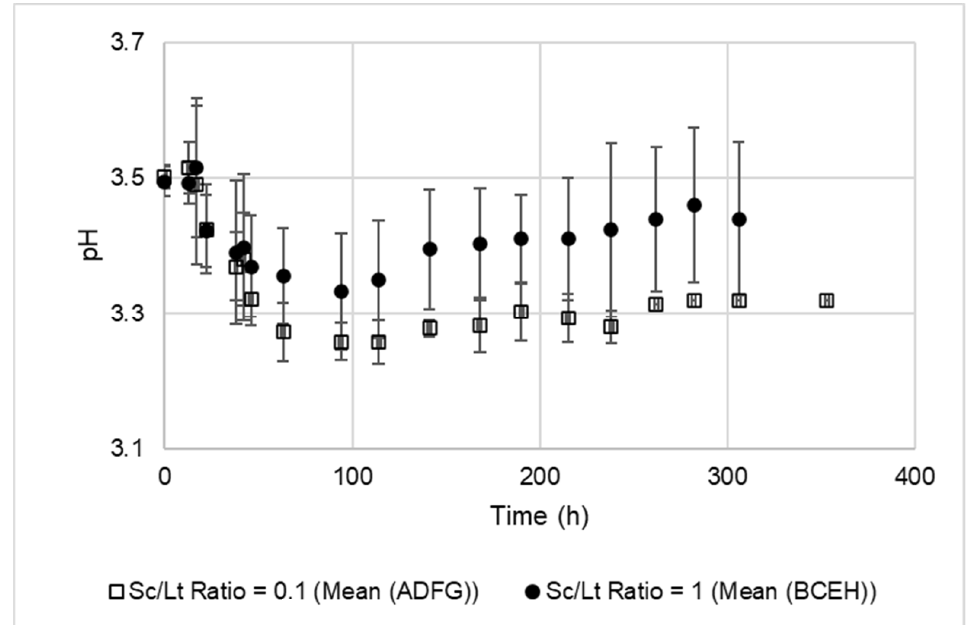
Figure 2. Evolution of pH during fermentation in mixed cultures with a Sc / Lt ratio of 0.1 or 1.